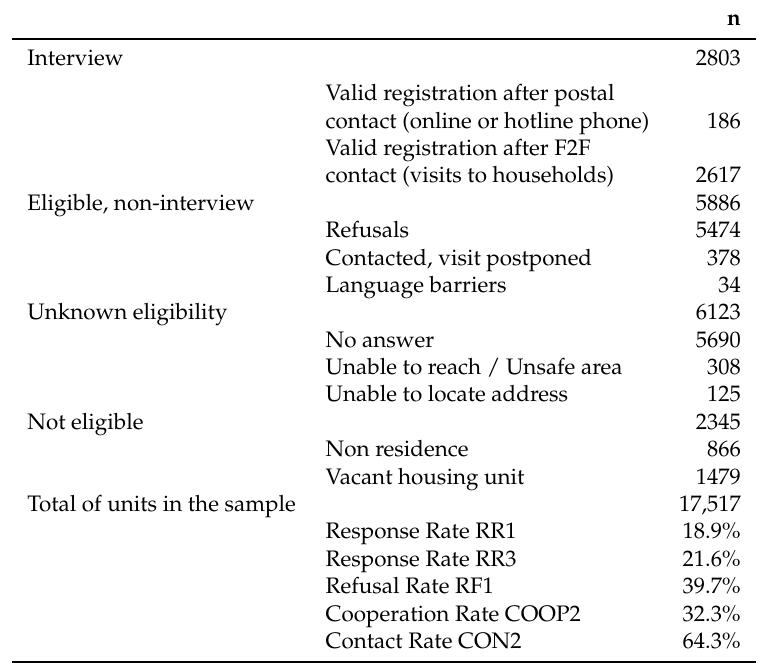
Table 1. Final disposition and outcome rates for the PACIS recruitment phase (face to face mostly).